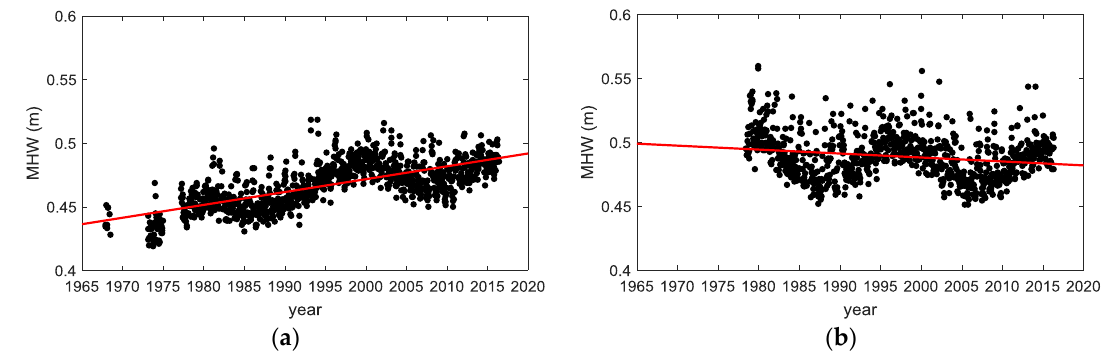
Figure 9. Temporal changes for the last few decades of the monthly averaged MHW at two NOAA stations: ( a ) Beaufort Station (ID: 6483); ( b ) Duck Station (ID: 1370). The red lines delineate the linearly best fit lines.